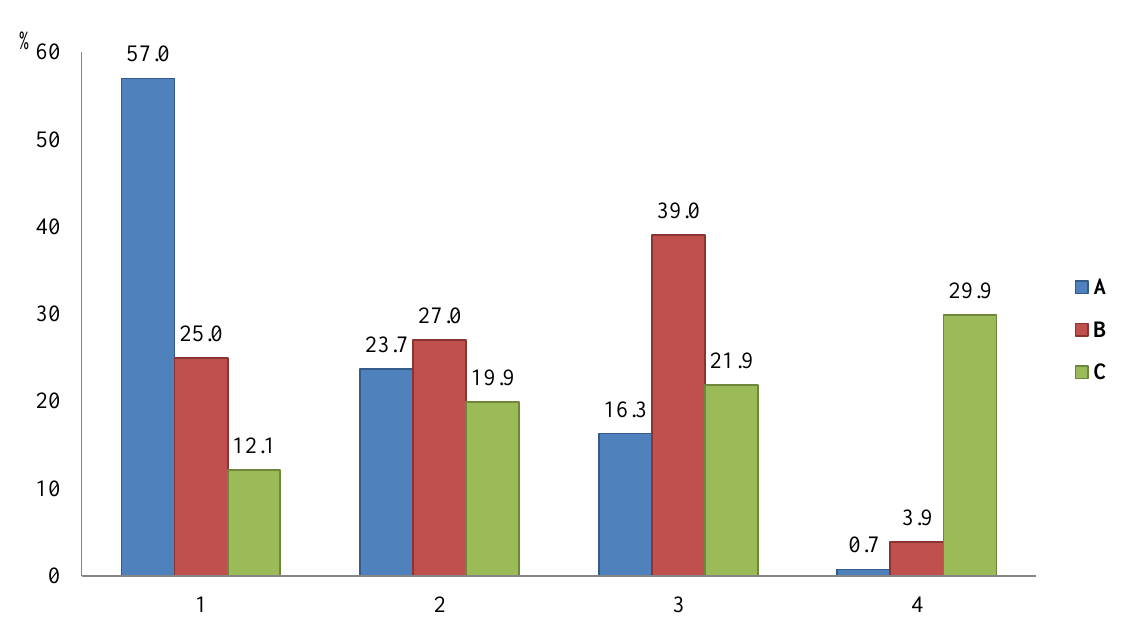
Fig.1. Degrees of schoolchildren’s activity at physical culture lessons: A - Main group; B – Preparatory group; C